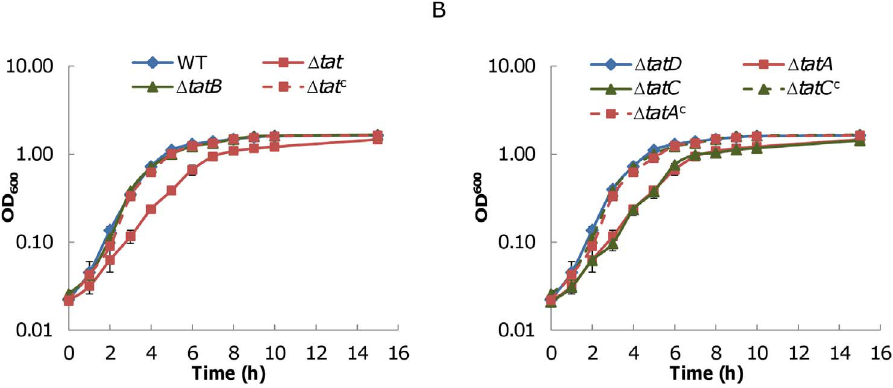
Figure 2. Growth of S.oneidensistat mutants under aerobic conditions. Fresh M1 defined medium was inoculated with overnight cultures grown from a single colony by 1:100 dilution, incubated on a shaker at 250 rpm at 30 u C under aerobic conditions, and growth was measured by recording cell densities of cultures at 600 nm. For clarity, mutants were presented in two panels, A and B. D tat c represents D tat ( D tatABC ) containing complementation vector pHG101- tatABC . D tatA c and D tatC c represent D tatA and D tatC containing complementation vectors pHG101- tatA and pHG102- tatC , respectively. Growth assays were performed at least three times, with the error bars representing the standard deviation.